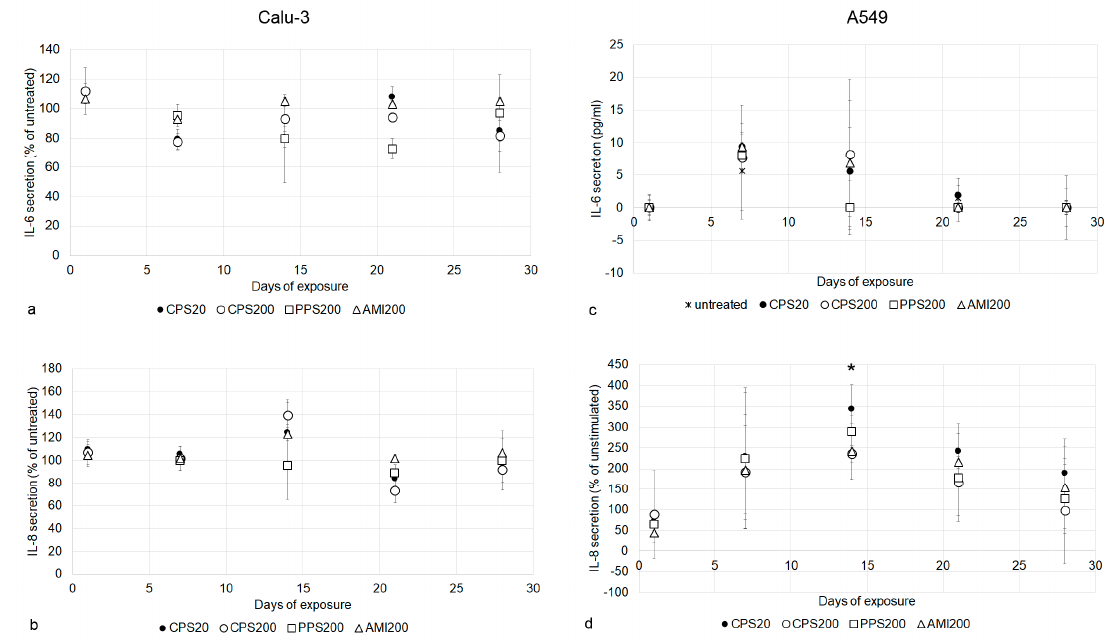
Figure 8. Cytokine levels of Calu-3 ( a , b ) and A549 ( c , d ) cells upon exposure to particles. Due to values below zero in the controls, IL-6 values for A549 cells ( c ) are indicated in pg/mL, while for the other exposures ( a , b , d ), relative changes compared to the not particle exposed cells are shown. Significant changes to controls are indicated by asterisks.